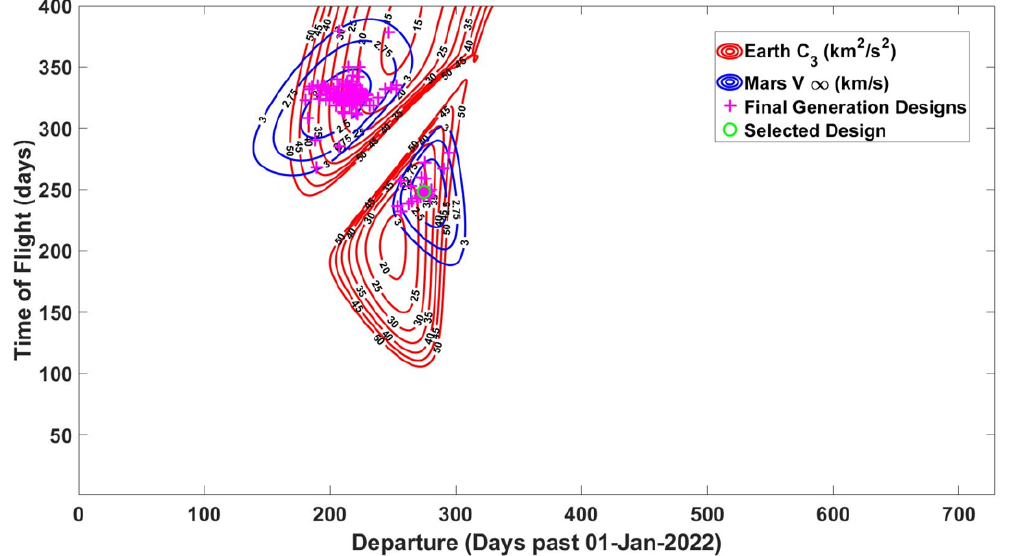
Figure 13. The figures of merit of the heliocentric cruise design problem shown on the Earth–Mars porkchop